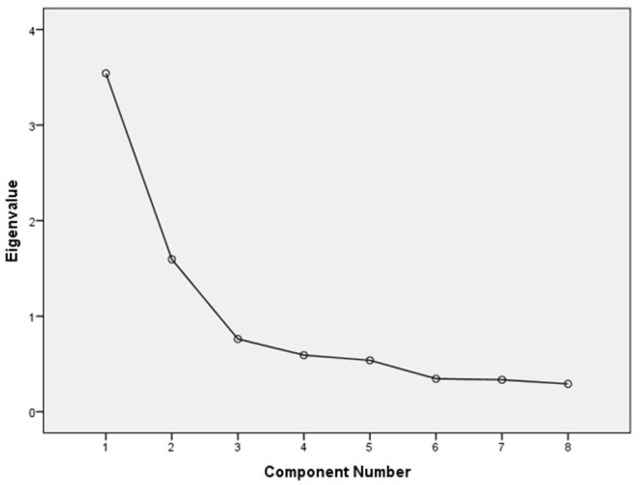
Scree plot of the EFA for the HRFS.